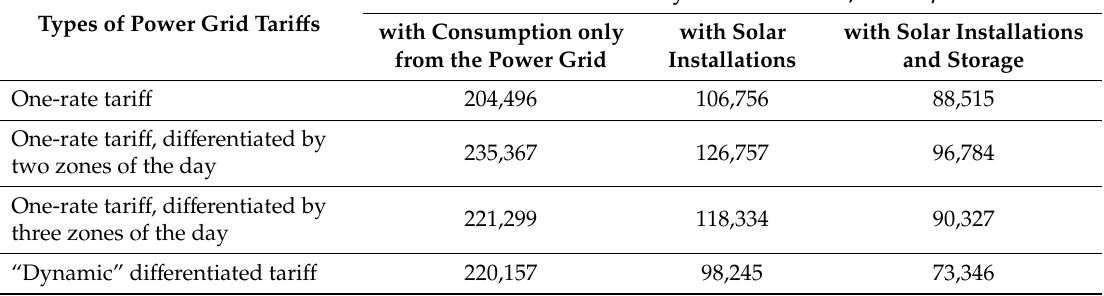
Table 3. Comparison of the results of calculating the cost of electricity for households according to the current tari ff menu and the proposed dynamic tari ff di ff